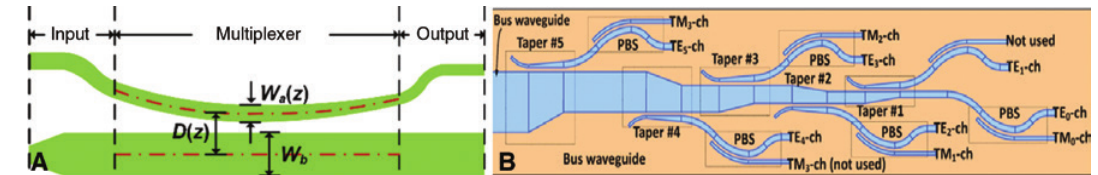
Figure 4: On-chip mode (de) multiplexers based on adiabatic waveguide structures. (A) Schematic configuration of an STA taper for mode (de) multiplexers [57]. (B) Schematic configuration of a 10-channel mode (de)